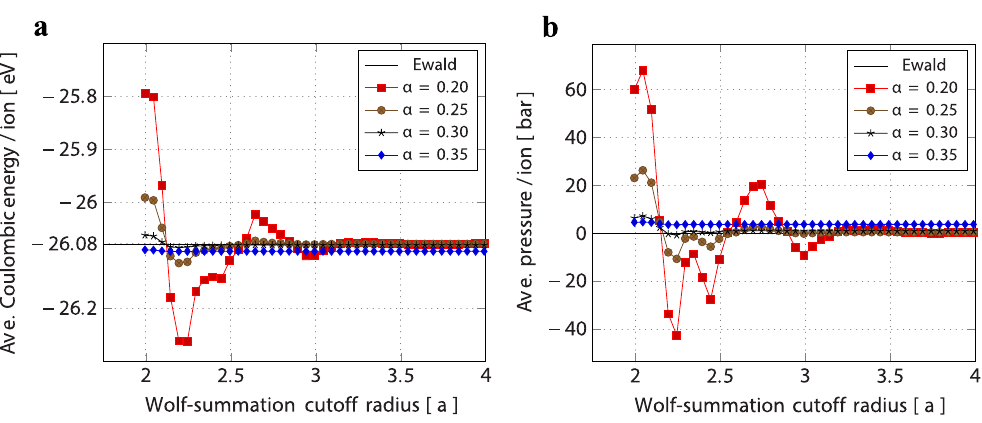
Figure 9. Effect of damping coefficient and cutoff radius in computing Coulombic energy and pressure. ( a ) Ewald summation is used as a standard for comparison of accumulated Coulomb energy per ion. ( b ) The pressure inside the system is sensitive to the damping coefficient. Computations are performed using a system of periodic 10 × 10 × 10 unit cells of rhombohedral BaTiO 3 at 0